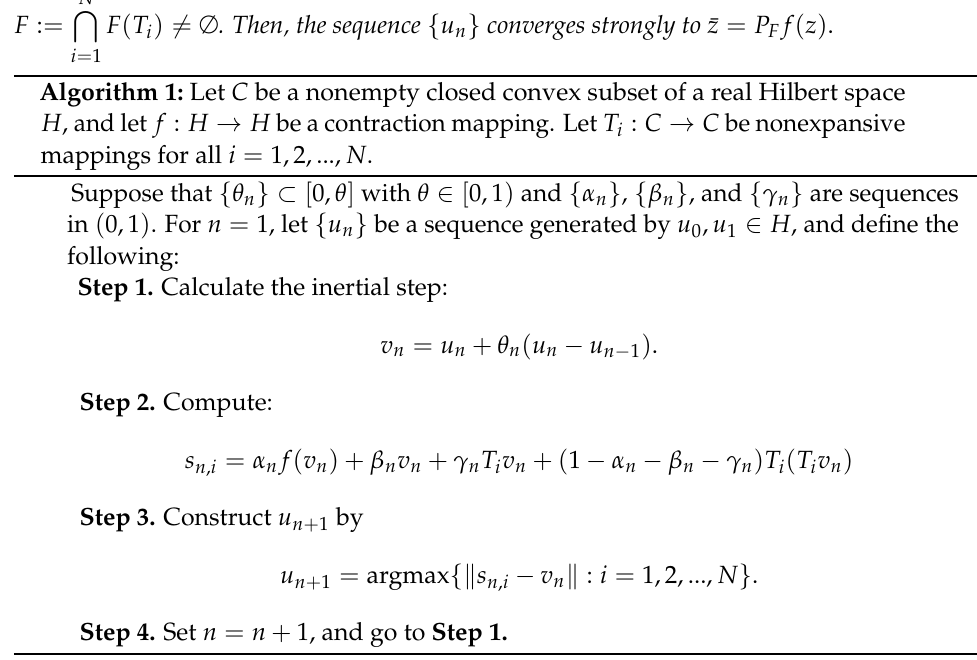
Algorithm 1: Let C be a nonempty closed convex subset of a real Hilbert